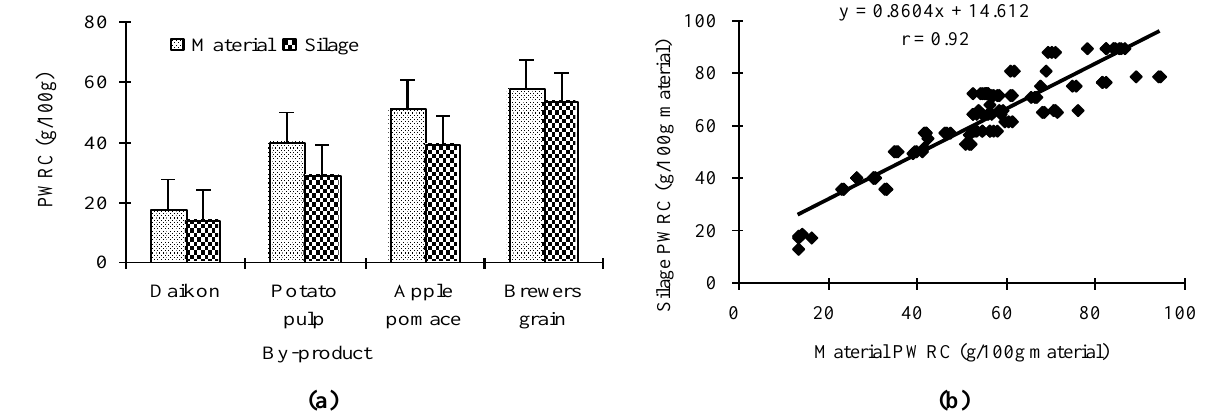
Figure 2. Potential water retention capacity of some HMBF materials and their silages with error bars (a), and regression equation showing the relationship between HMBF materials used in the study and their silages (b) (n =